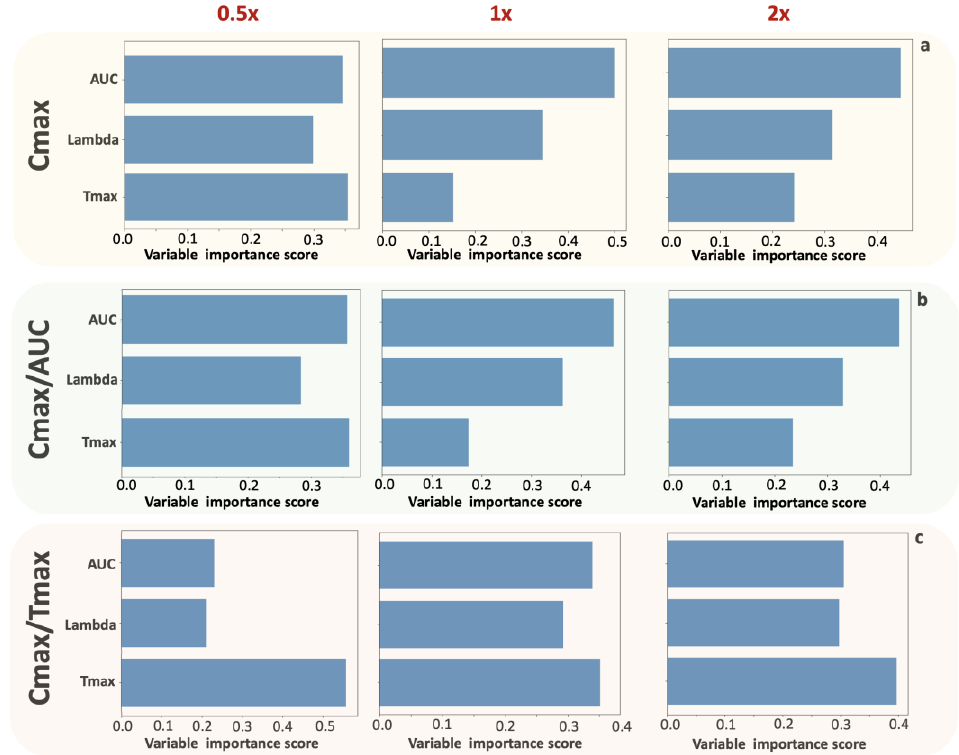
Figure 7. Variable importance scores for the feature parameters for the simulated bioequivalence studies. The response variable was either Cmax ( a ), Cmax/AUC ( b ), or Cmax/Tmax ( c ). Three levels of the simulated absorption rate constant were assumed: 0.5x, 1x, and 2x. Thus, in total, nine Random Forest models were developed.